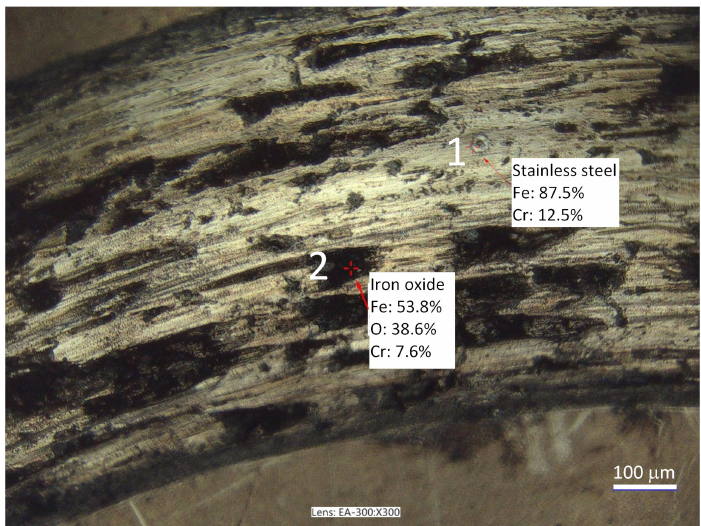
Figure 8. Compositional analysis and phase identification in two spots of the wear track of the simply CrN-coated sample. Spot 1: a highly stripped region, Spot 2: an area covered by black smoke assumed to be the Fe 3 O 4 tribofilm.